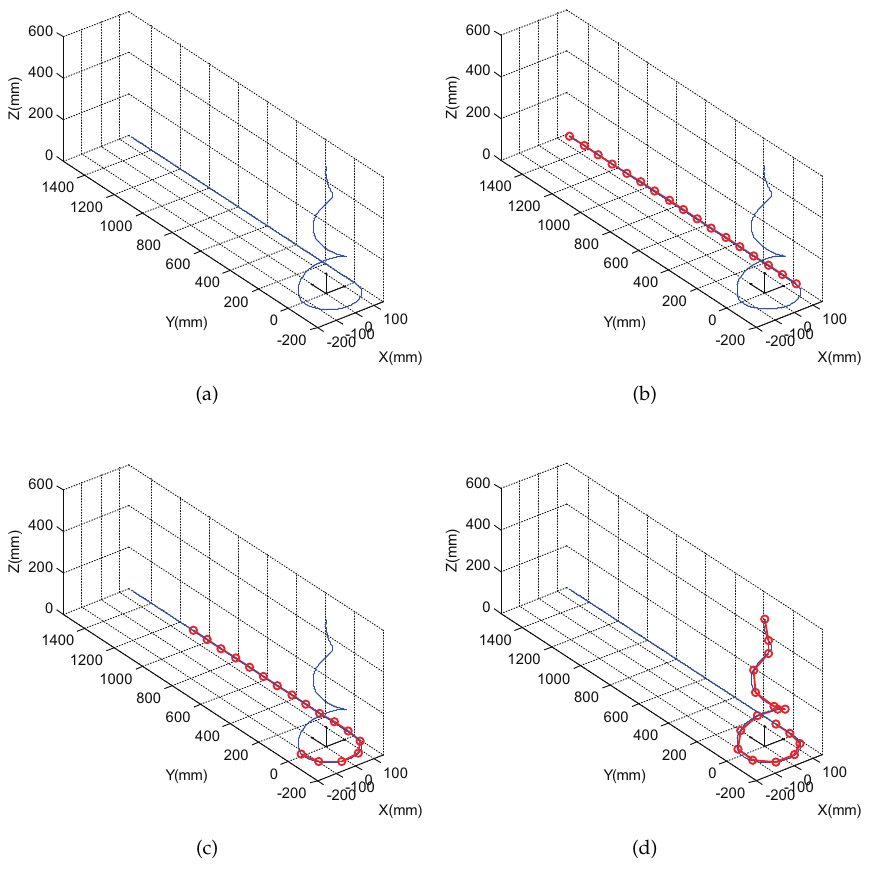
Figure 9. Phase-shifting process: ( a ) predefined spiral curve, ( b ) i = 1, t = ˆ t 1 , ( c ) i = 147, t = ˆ t 2 , ( d ) i = 500, t = ˆ t 3